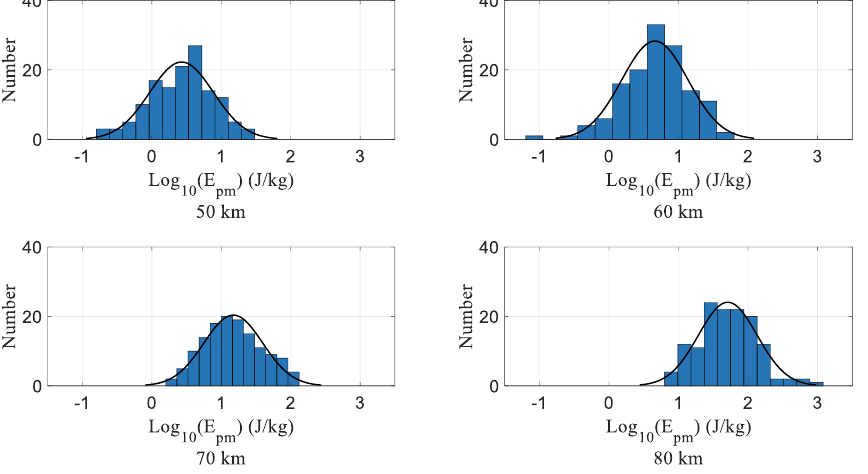
Figure 3. Histograms of the logarithmic distribution of E pm at 50 km, 60 km, 70 km and 80 km in the mesosphere; the black line is the Gaussian distribution fitting of the data.